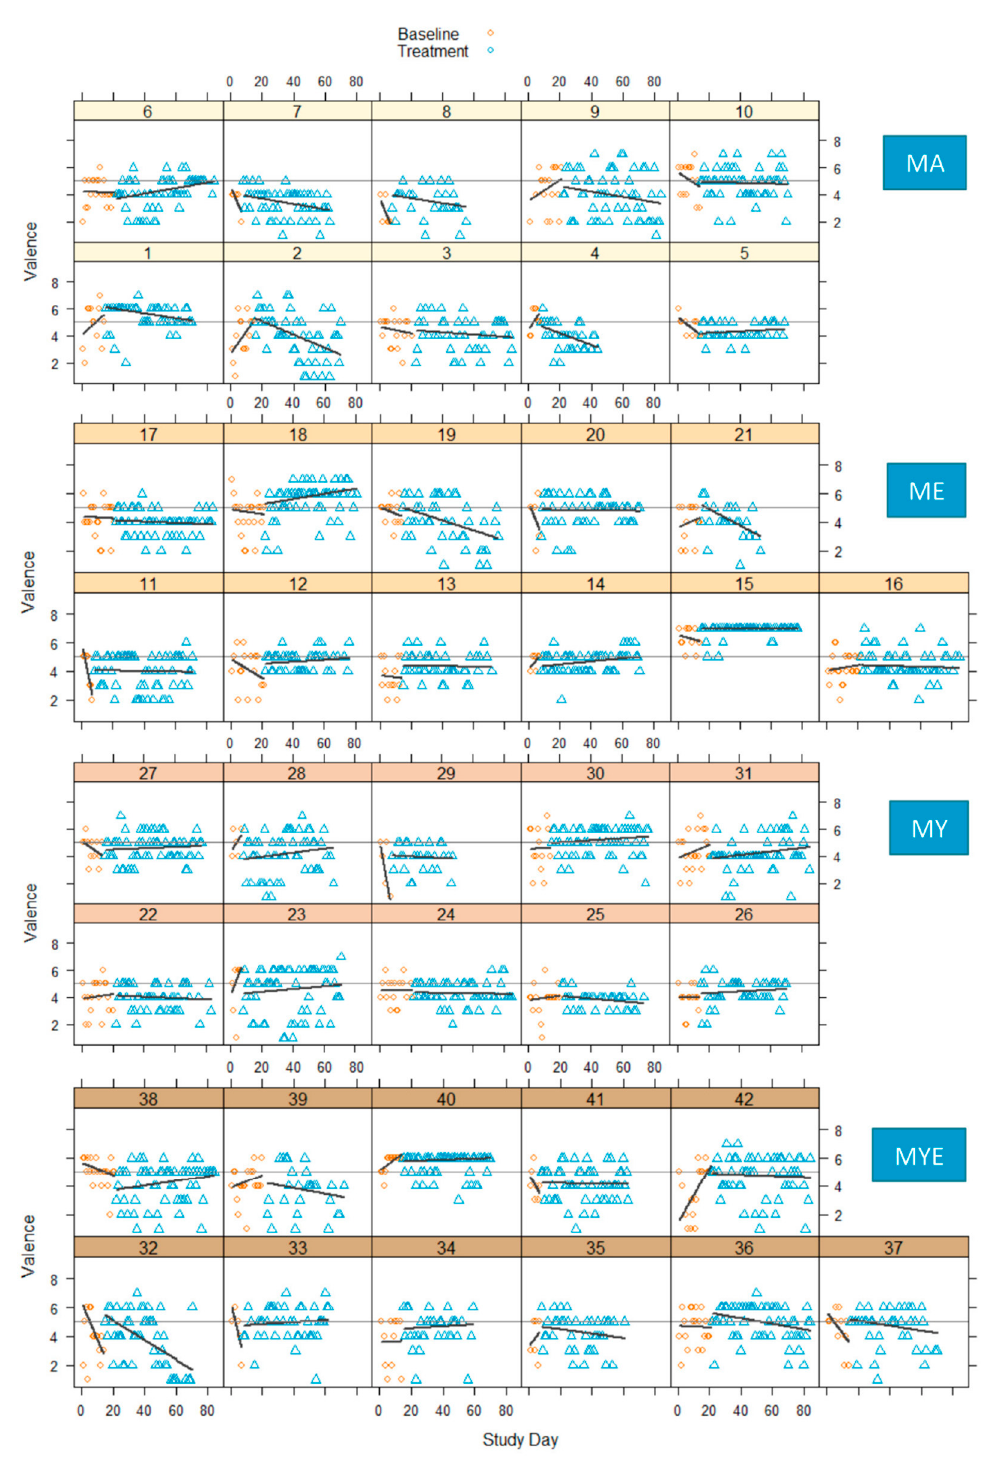
Figure 5. Valence scores in four conditions during baseline and treatment phases for each participant with regression lines for each phase. Note . Thin horizontal line represents a neutral valence (value = 5); MA = mantra meditation only; ME = meditation and ethical education; MY = meditation and physical yoga; MYE = meditation, physical yoga, and ethical education.